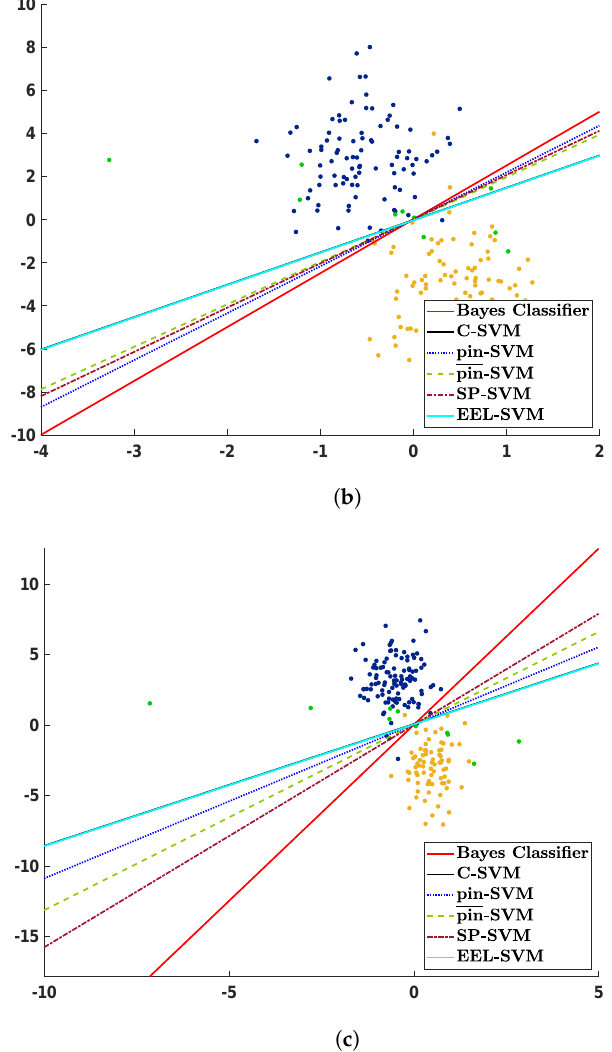
Figure 1. Classification boundaries for five SVM classifiers if DU is induced by ( a ) normal distribution, ( b ) Student’s t distribution with 5 degrees of freedom and ( c ) Student’s t distribution with 1 degree of